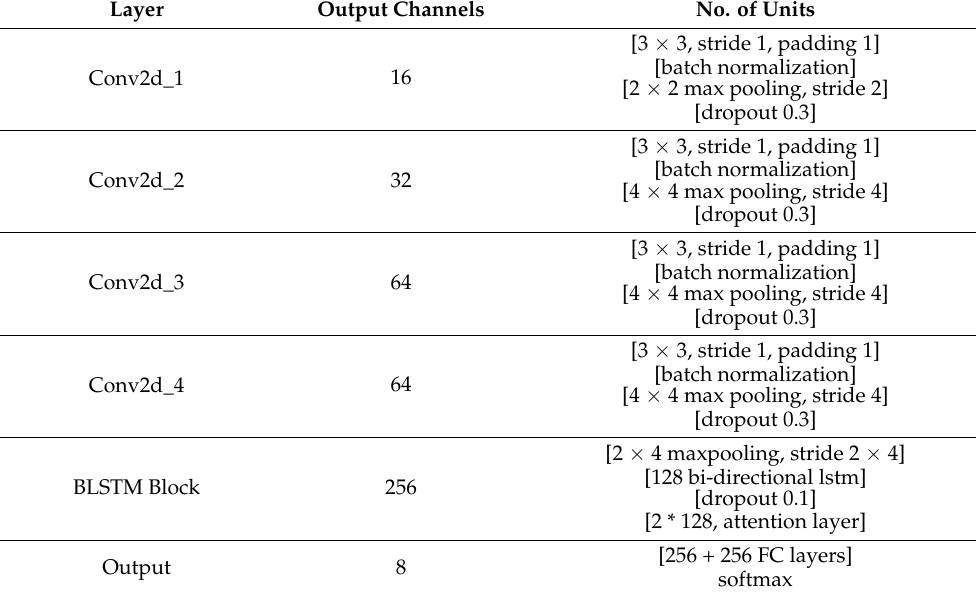
Table 4. Overall specification of Parallel-CNN-BLSTM-Attention network with set of layer sizes, output sizes, and number of